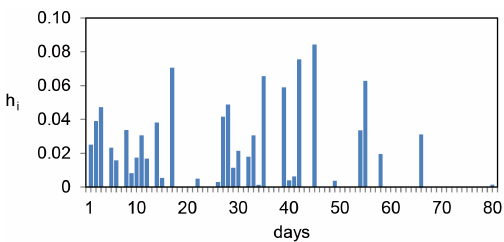
Figure 14. Uncino landslide case study. Average kernel obtained from the 100 best filter functions.